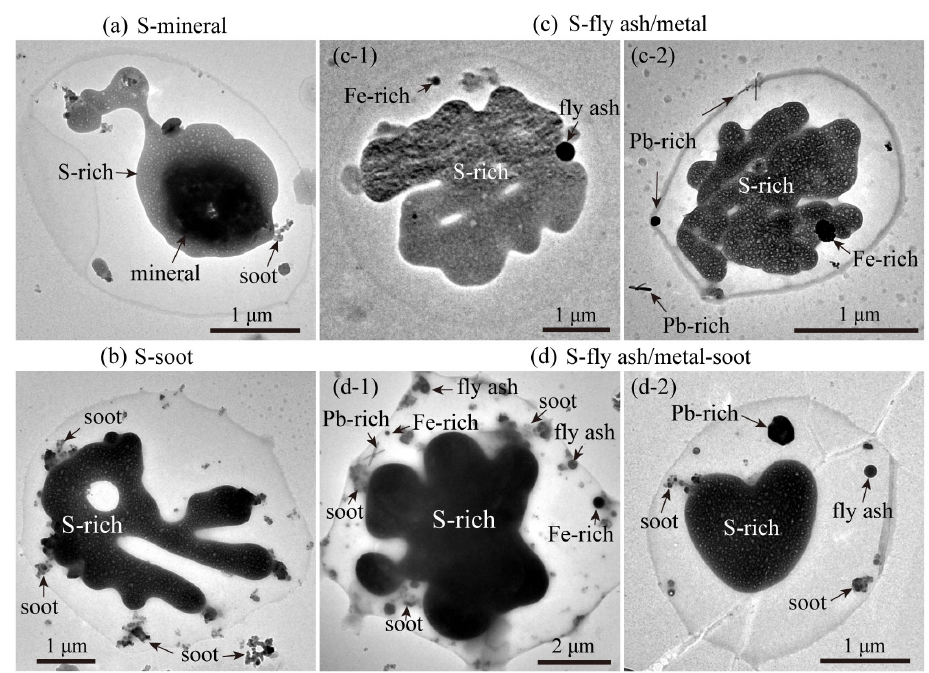
Figure 4. Typical TEM images showing mixing properties of multicomponents within individual cloud RES particles: (a) a mixture of S-rich and mineral particles; (b) a mixture of S-rich and soot particles; (c) a mixture of S-rich and fly ash/metal particles; and (d) a mixture of S-rich, soot, and fly ash/metal particles.